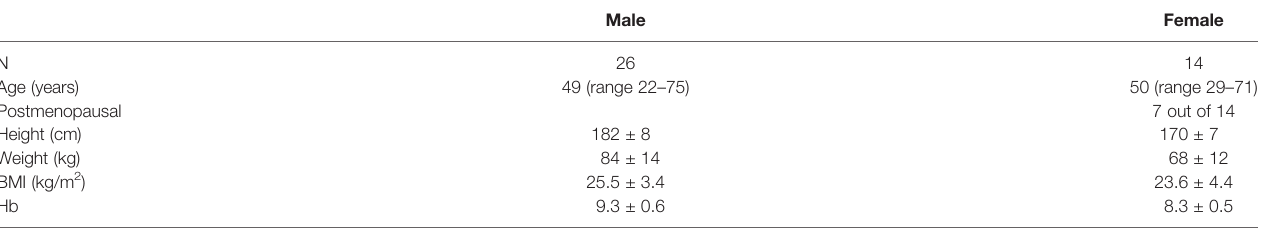
TABLE 1 | Subject characteristics, mean ±